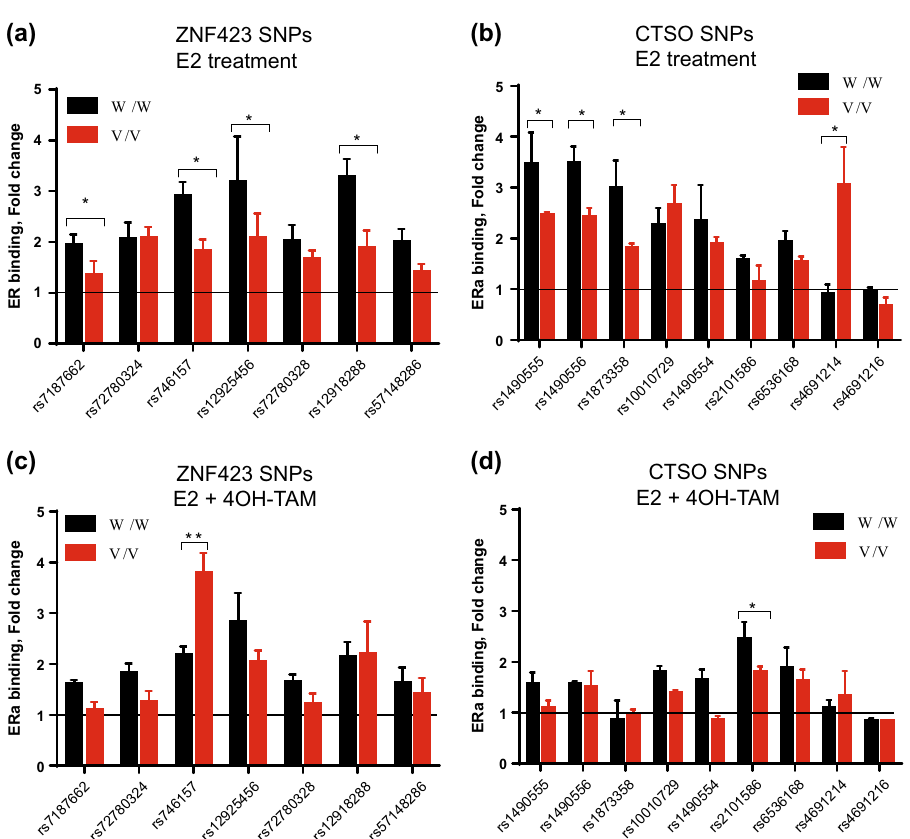
Fig. 2 ChIP assays showing fold changes in ER α binding to DNA sequences containing ZNF423 SNPs (panels a and c ) or CTSO SNPs (panel b and d ). ChIP assays were performed in LCLs homozygous for WT (W/W) or variant (V/V) genotypes for these SNPs after exposure to E2 (0.01 nM) or E2 (0.01 nM) plus 4OH-TAM (0.01 μ M). Percentage of ChIP DNA/input was determined by qPCR. The level of enrichment was expressed as relative enrichment above vehicle treatment. The values shown represent mean ± SEM for six determinations.* P < 0 .05, ** P <